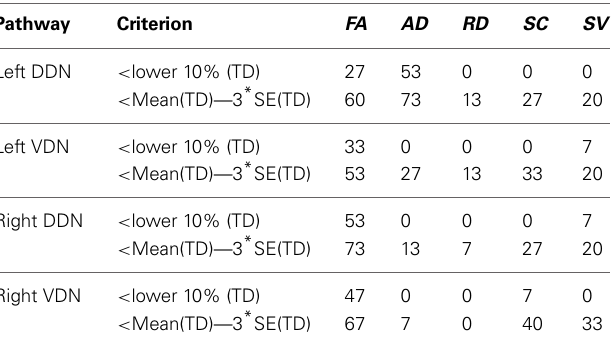
Table 3 | Percentage of children with ASD showing significant changes in diffusivity parameters in the pathways connecting the cerebellar cortex with the dentate nuclei compared to the values of the TD